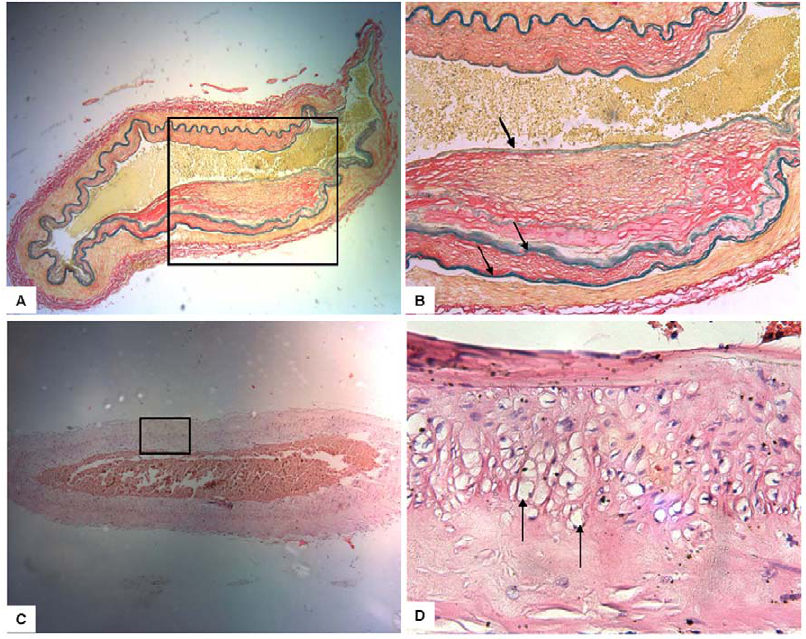
Figure 4. Photomicrographs of brain vessels in MMD patients. A and B: narrow lumen with intimal thickening and attenuation of media in middle cerebral artery (Ponceau/Victoria blue staining, A: 6 40, B: 6 100), black arrows indicate stratified internal elastic lamina, Figure 4B is an enlarged region (box) of Figure 4A; C and D: vacuolar degeneration (black arrows) in cerebrovascular smooth muscle cells (H&E staining, C: 6 40, D: 6 100), Figure 4D is an enlarged region (box) of Figure 4C.